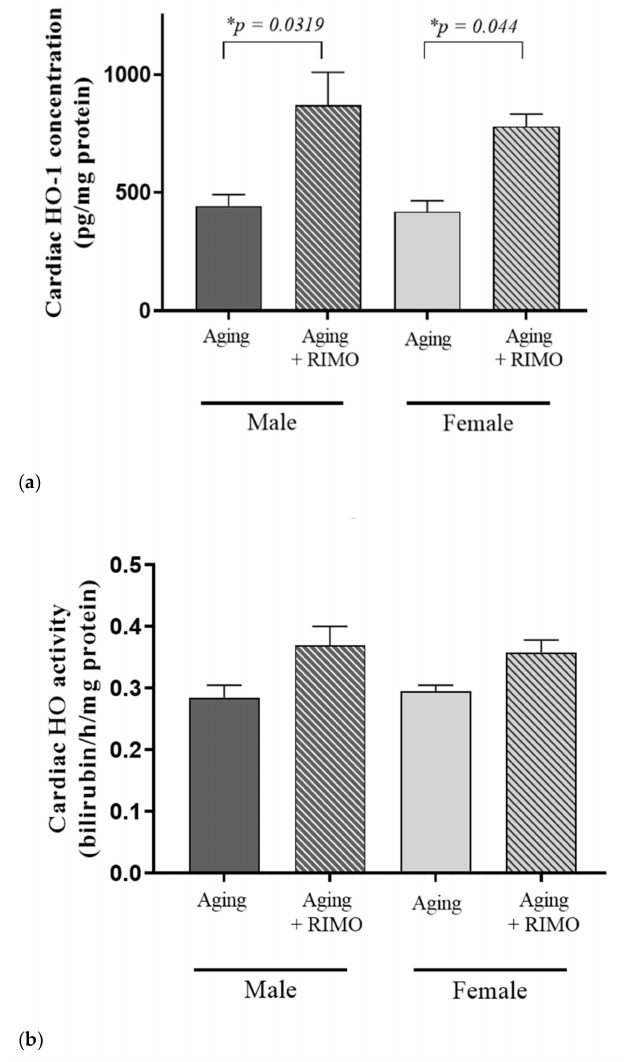
Figure 2. ( a ) The effects of rimonabant treatment on cardiac HO-1 concentration in aged animals (HO-1 expressed as pg/mg protein). Results are shown as means S.E.M. n = 4–7. * p < 0.05: Statistical significance between rimonabant-treated and untreated, sex-matched aging rats, RIMO = rimonabant, HO-1 = heme oxygenase-1. ( b ) The effects of rimonabant treatment on cardiac HO activity in aged animals. (HO; expressed as nmol bilirubin/h/mg protein). Results are shown as means ± S.E.M. n = 4–7. RIMO = rimonabant, HO = heme